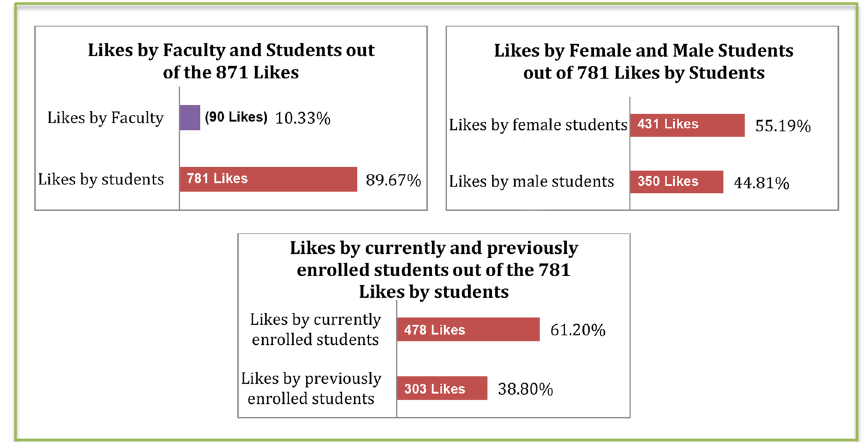
Fig. 6 Bar charts presenting the number and percentage of likes made in the group in regards of “Who” made them